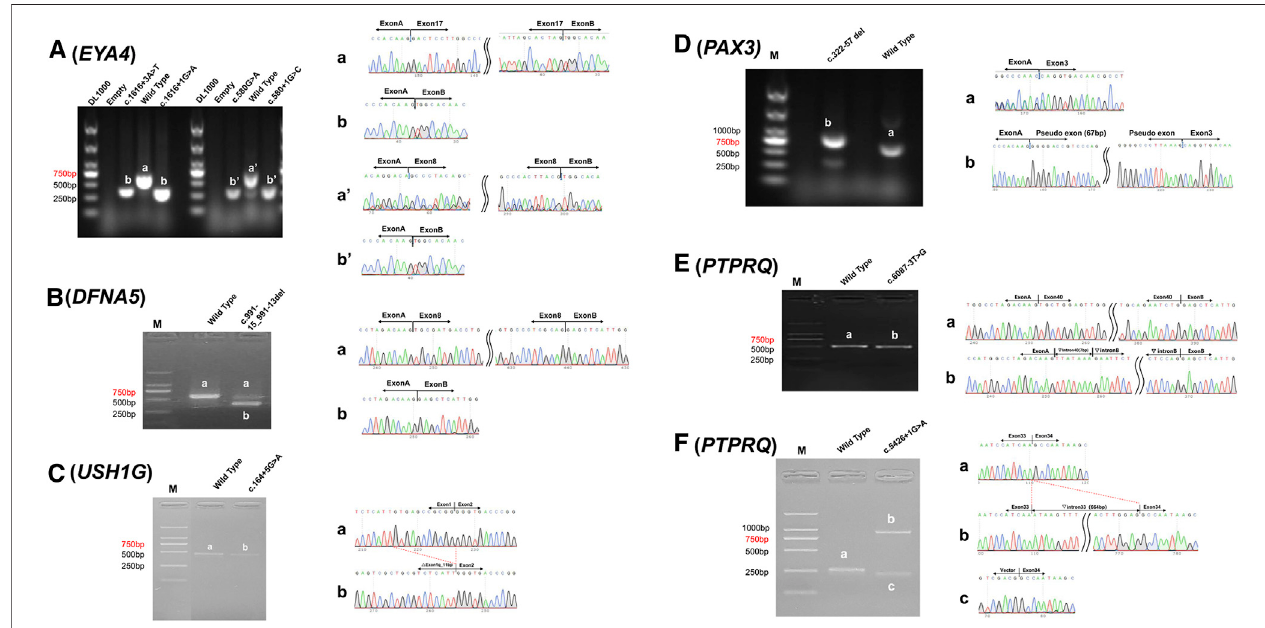
FIGURE 3 | Minigene assay analysis of c.1616+3A > T and c.580G > A in EYA4 (A) , c.991-15_991-13del in DFNA5 (B) , c.164+5G > A in USH1G (C) , c.322- 57_322-8del in PAX3 (D) , c.6087-3T > G (E) , and c.5426+1G > A (F) in PTPRQ. left column. Reversed transcriptional analysis showing distinct bands (a, b, a ′ and b ′ ); right column. Sequencing results of the corresponding